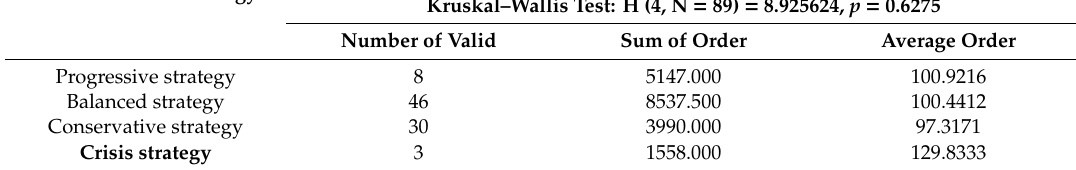
Dependent Variable: Type of E-Commerce Strategy